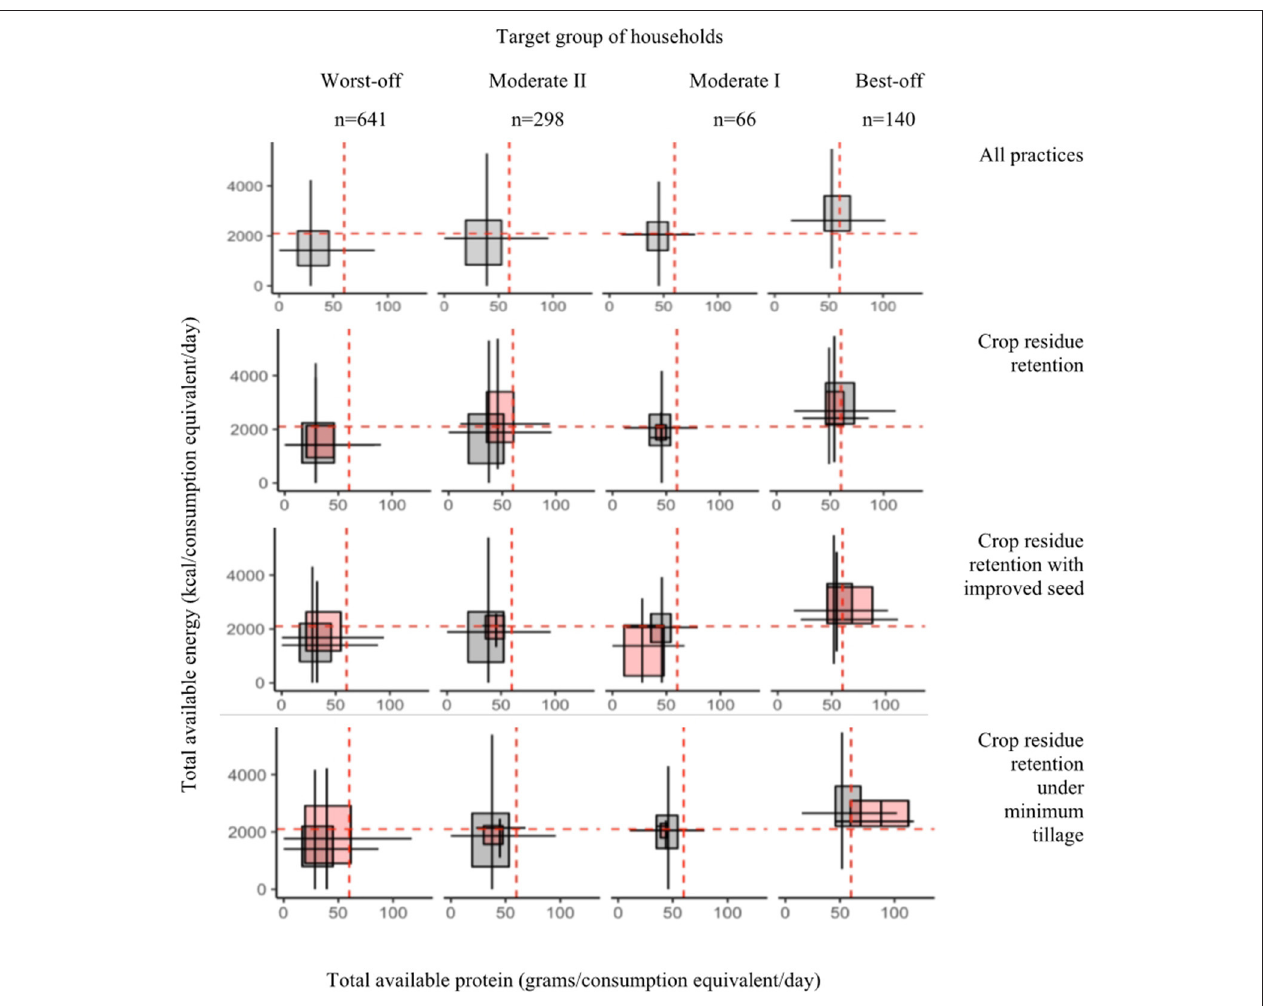
FIGURE 1 | Model for the estimation of food sufficiency showing three sources of food; Household livestock production, food purchase from off-farm activities and on-farm crop